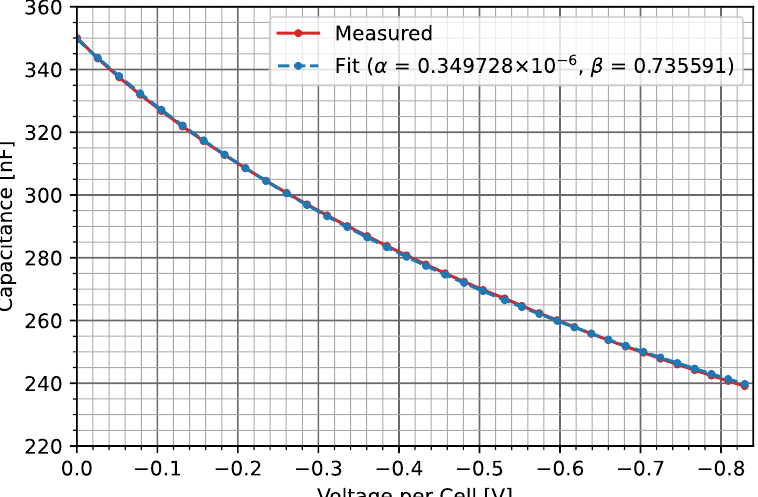
Figure 29. Small PV module measured and fit per-cell capacitance curves at multiple levels of reverse